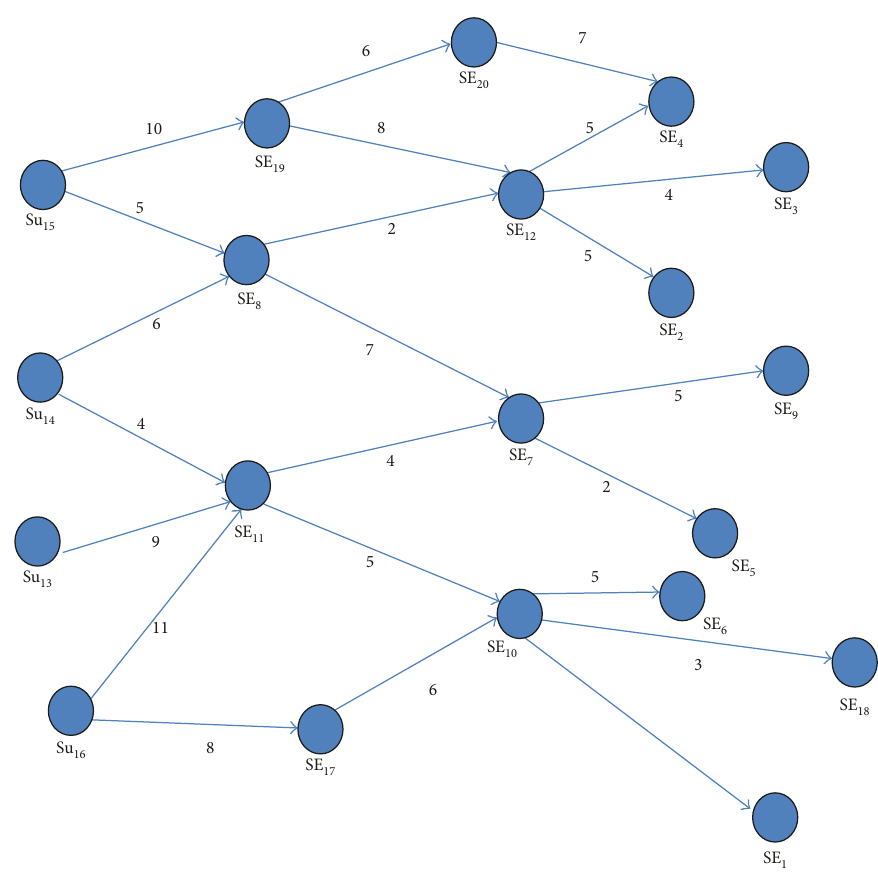
Figure 1: m-Health scenario routing traffic from the source to the